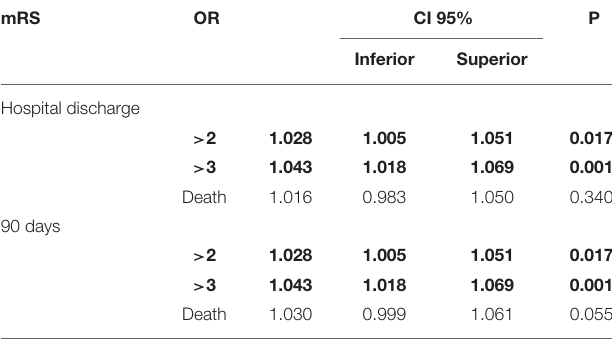
TABLE 2 | Analysis of binary logistic regression considering age in years as the variable of interest and mRS > 2, mRS > 3, and death (mRS = 6) at hospital discharge and 90 days after stroke as the outcome